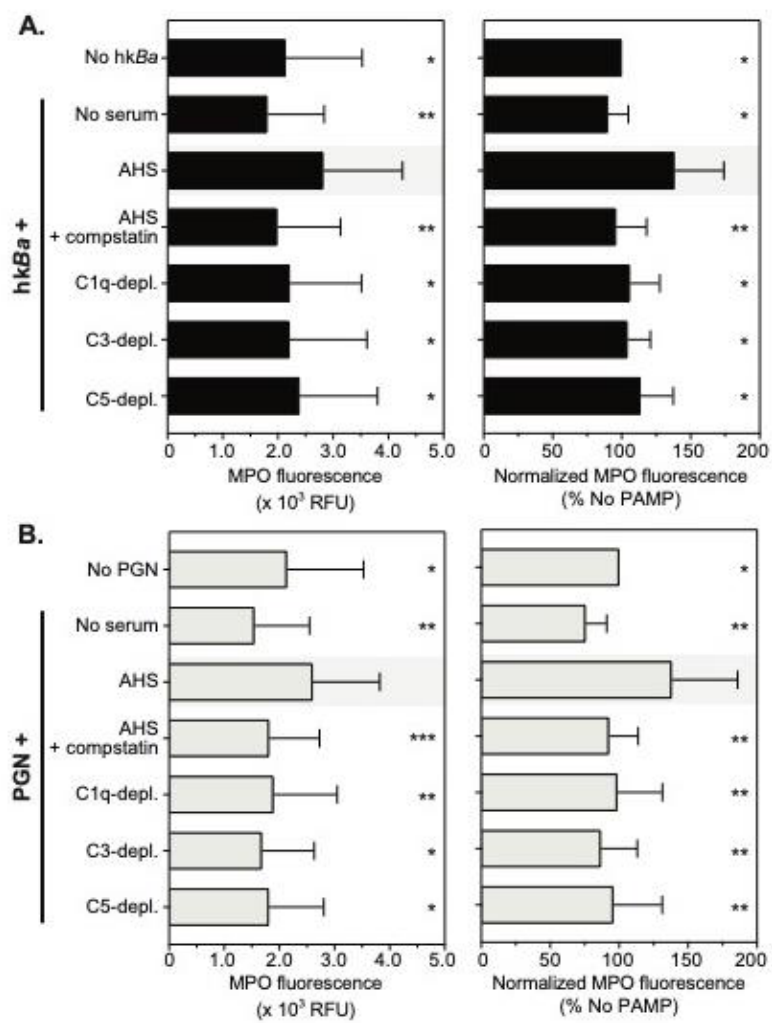
Figure 5. Flow cytometry quantitation of myeloperoxidase (MPO) immunoreactivity in neutrophils stimulated with hk Ba ( A ) or PGN ( B ) in the presence of compstatin, a C3 convertase inhibitor, or the immunodepletion of complement factors. Data are shown as mean ± SD of 10 independent donors and the depict intracellular MPO fluorescence (geometric mean) in CD16 high neutrophils (left) or the changes in MPO fluorescence after paired normalization to control MPO immunoreactivity in the absence of agonists (right panel). Statistically significant differences compared to bacteria and/or PGN-induced MPO immunoreactivity in the presence of the autologous serum (AHS, shaded) are depicted graphically (* p < 0.05; ** p < 0.01; *** p < 0.001), and were computed by repeated measures one-way ANOVA with Holm–Sidak’s multiple comparisons tests.